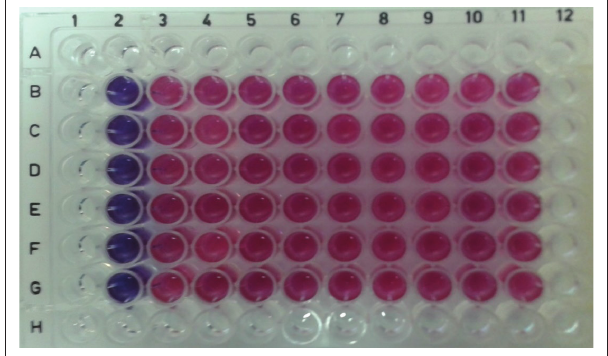
FIGURE 1-A1: Plate A.1 – Inactivity effect of volatile oils from solvent-free microwaved essential and hydrodistilled on Mycobacterium tuberculosis on a 96-well microtitre plate showing: Well A1–12; H1–12: Sterile water; well 2 (Control 1): 100 µ L medium and 100 µ L of 500 µ g/mL volatile oil; no Mycobacterium tuberculosis ; well 3 (Control 2): 100 µ L medium and 100 µ L Mycobacterium tuberculosis inoculums; well 4 (Control 3): 100 µ L medium containing 1 % absolute ethanol and 100 µ L Mycobacterium tuberculosis inoculum; wells 5–11: (250, 125, 67.5, 31.3, 15.6, 7.8, 3.9 µ g/mL); B, C, D: oil from solvent-free microwaved essential and E, F, G: oil from hydrodistilled.